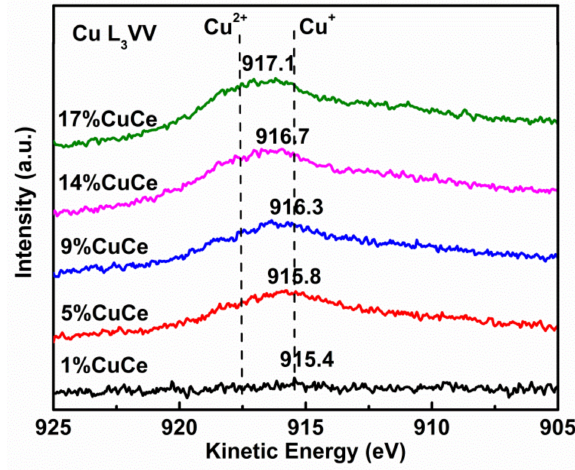
Figure A4. Kinetic energy spectra of Cu L 3 VV